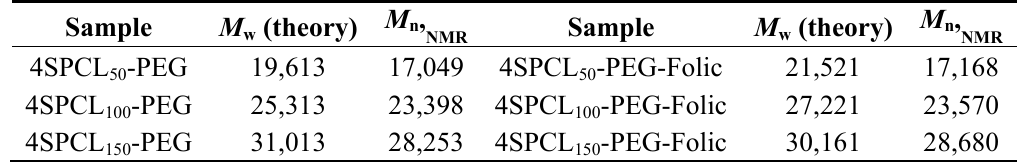
Table 1. Properties of prepared copolymer with various feed weight ratios of star-shaped